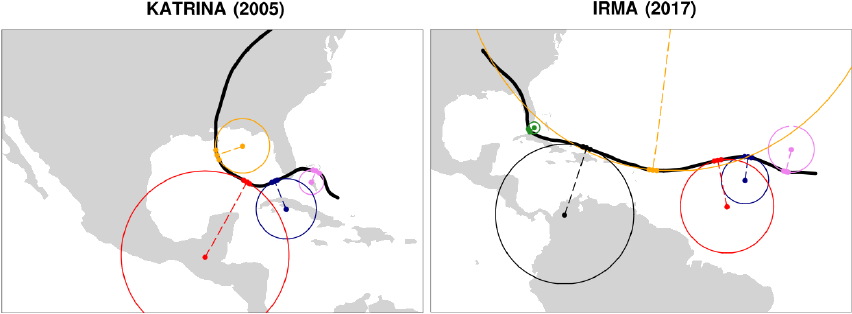
Figure 1. Illustration of the circle-fit and radius-of-curvature calculations at five selected locations along the track of hurricanes Kat- rina (2005) and Irma (2017).